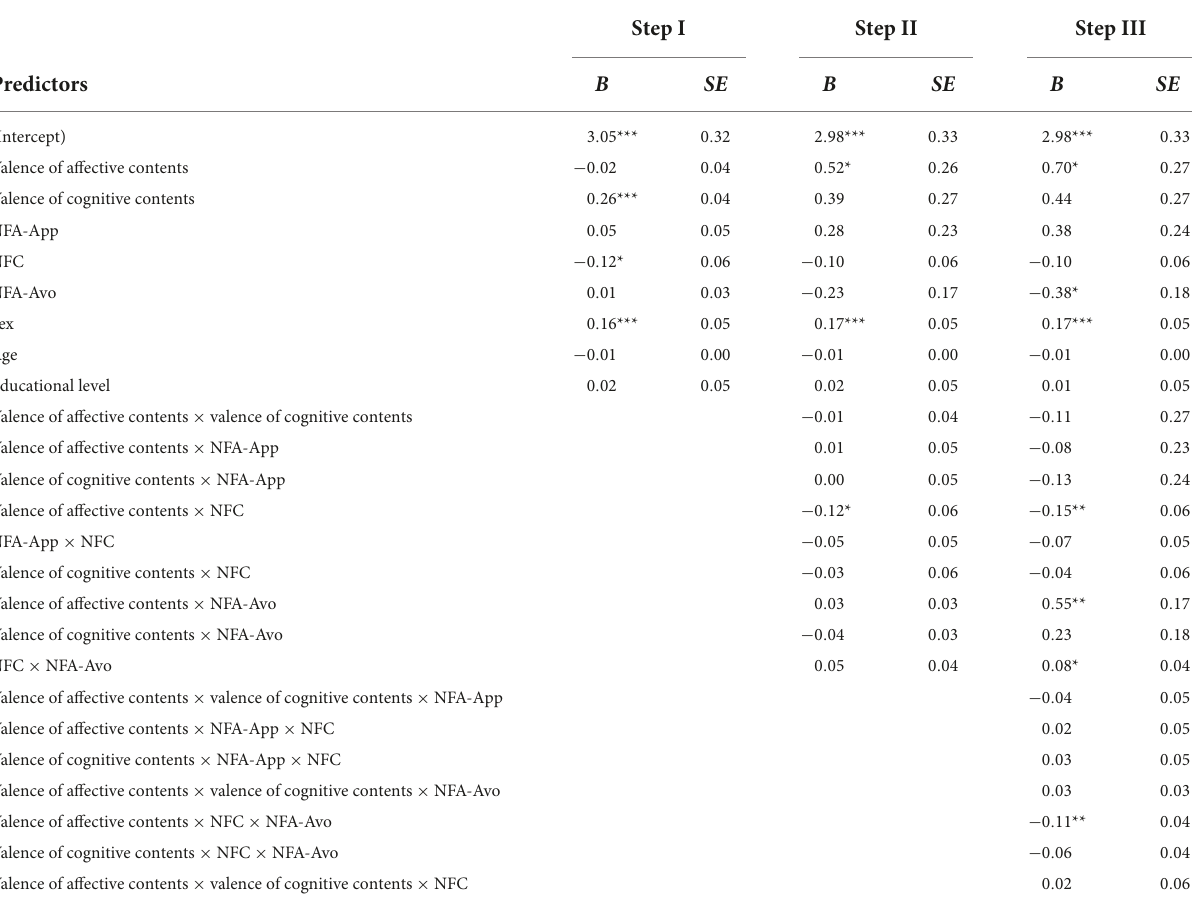
TABLE 2 Moderated regression